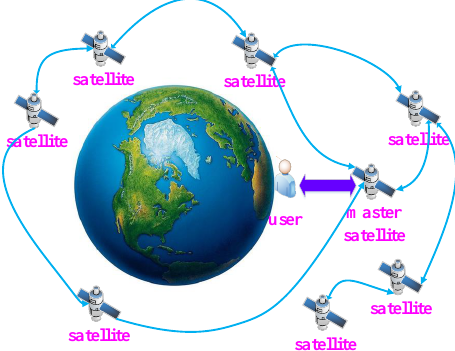
Figure 3. System structure diagram of this work.